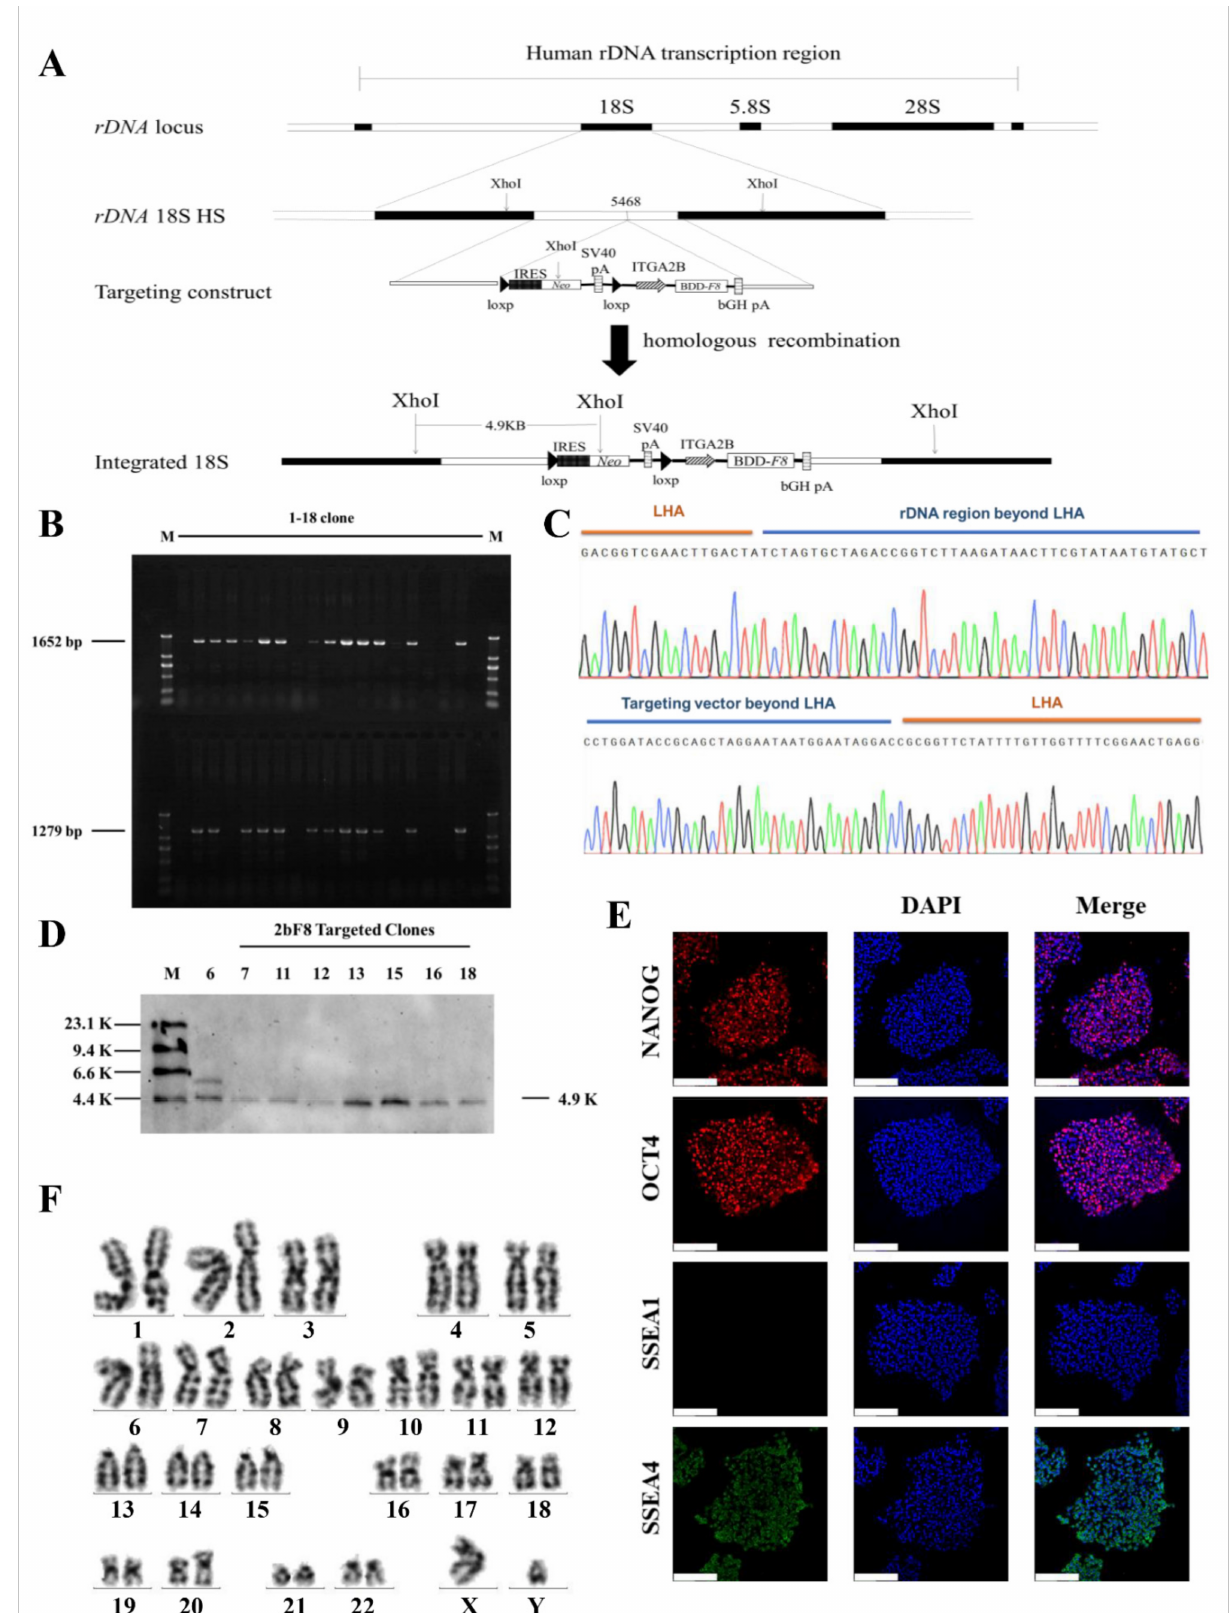
Figure 2. Gene targeting and screen. ( A ) The schematic diagram of gene targeting into the human rDNA locus. ( B ) Eighteen candidate targeted clones were picked and expanded, followed by genomic DNA extraction and PCR. The site-specific integrated clones obtained a 1652 bp band and a 1279